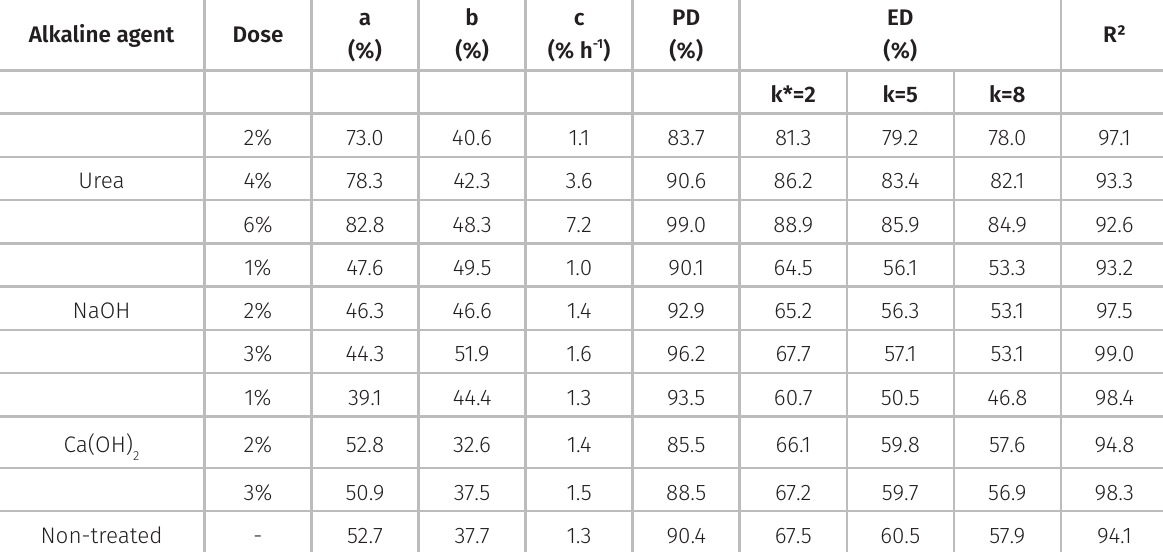
Table III. Soluble ( a ) and potentially degradable ( b ) fractions, degradation rate ( c ), potential (PD) and effective (ED) degradability, and coefficient of determination (R²) for crude protein of sugarcane tip hay treated or not with alkaline agents.